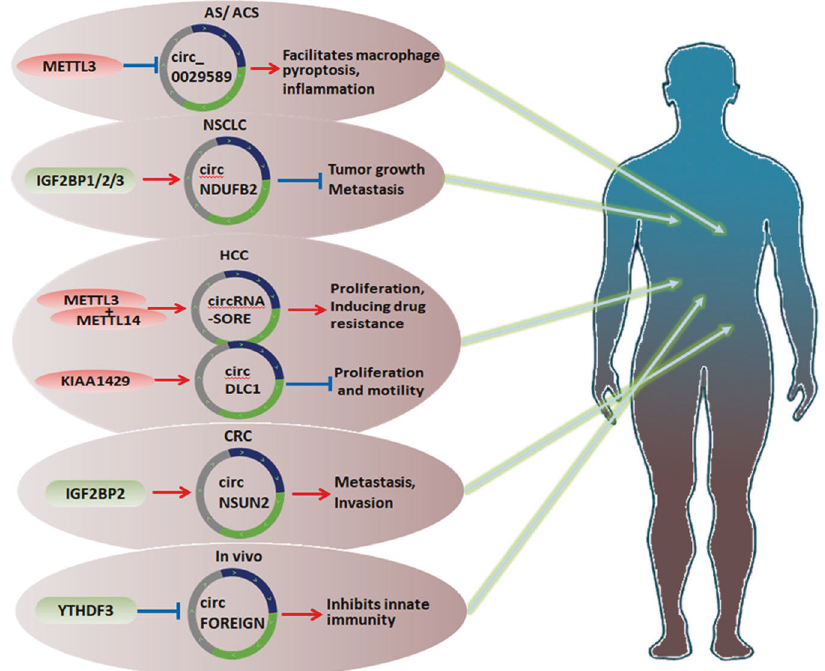
Fig. 3 Multiple metabolisms and functions of m 6 A regulators with circRNAs in the human body. In head and neck squamous cell carcinoma, colorectal cancer, non-small-cell lung cancer, atherosclerosis, acute coronary syndrome, and in vivo, m 6 A regulators with circRNAs exert various effects, such as facilitating macrophage pyroptosis, in fl ammation, metastasis, and